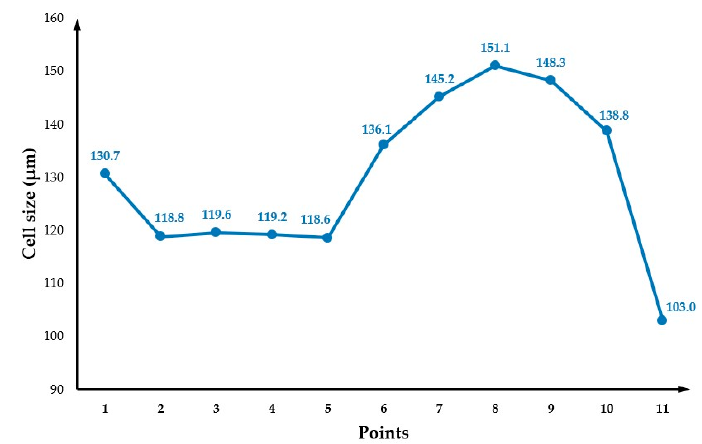
Figure 5. The cell size variation across the cross-section.